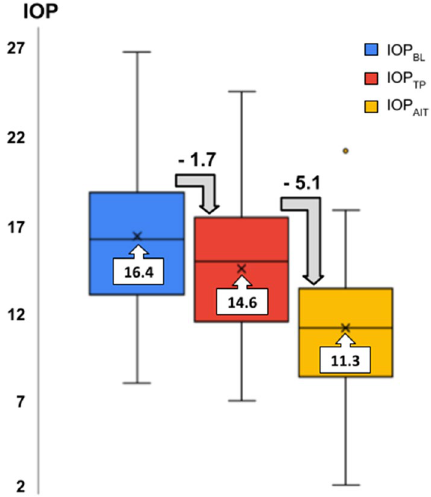
Figure 2. Intraocular pressure (IOP) levels at baseline and post intervention. Boxplots for mean IOP levels at Baseline (IOP BL ), post trabeculopuncture (IOP TP ), and post ab interno trabeculectomy (IOP AIT ). The figures above the grey arrows correspond to the mean IOP reduction after trabeculopuncture and ab interno trabeculectomy, respectively.